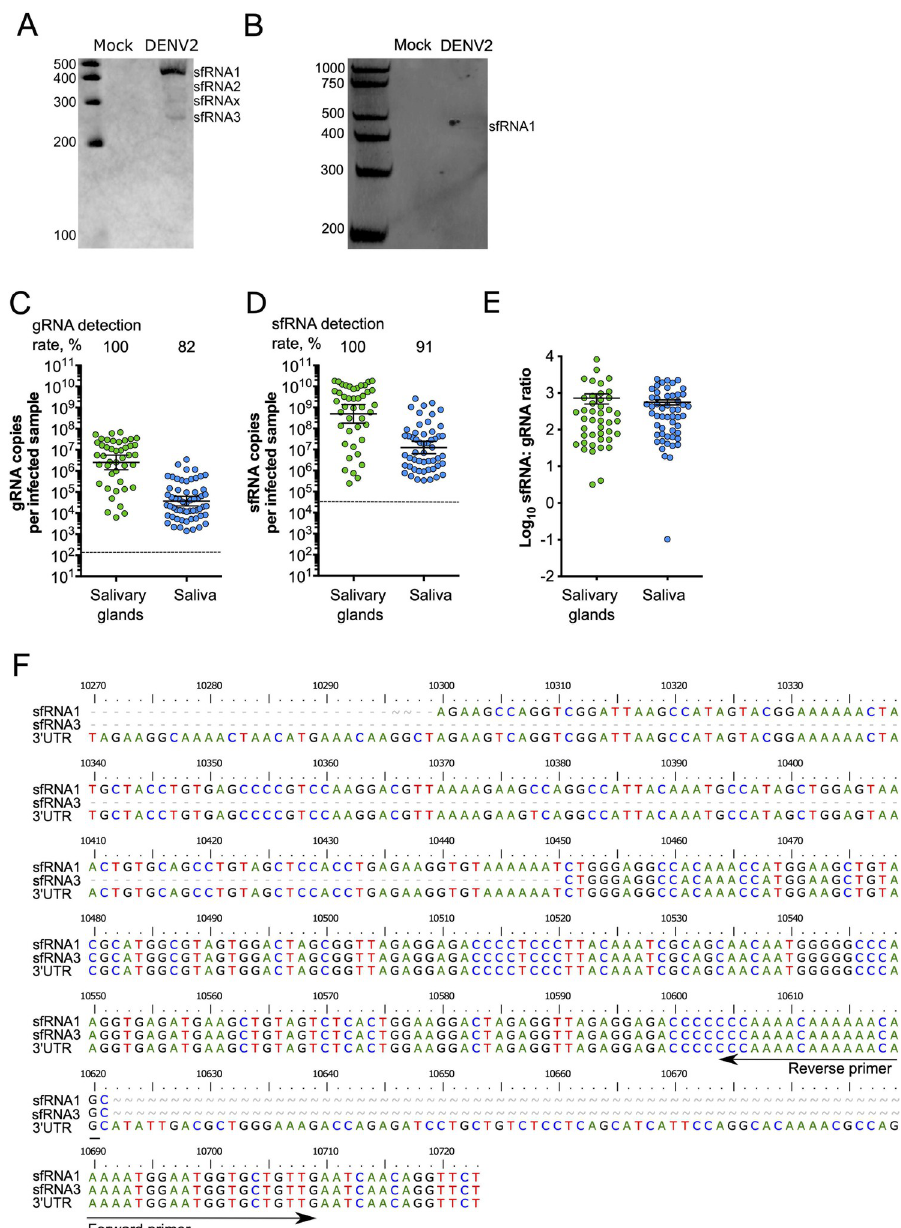
Fig 1. Detection of sfRNA in mosquito saliva. ( A ) sfRNA species detected by Northern blotting in infected mosquitoes. (B) sfRNA1 detected by northern blotting in infected pooled mosquito saliva. ( C ) gRNA; ( D ) sfRNA; and ( E ) sfRNA:gRNA ratio in salivary glands and saliva determined by qRT-PCR. Points represent a pair of salivary glands, or one saliva collected from one mosquito. ( C - D ) Bars represent geometric means ± 95% C.I. and dashed lines indicate limit of detections which were 133 copies in gRNA ( C ) and 31,216 copies in 3’ UTR/ sfRNA1 ( D ). ( E) Bars represent arithmetic means ± s.e.m. N salivary glands, 43; N saliva, 71; from two mosquito batches. ( F ) Sequences of sfRNA species found in